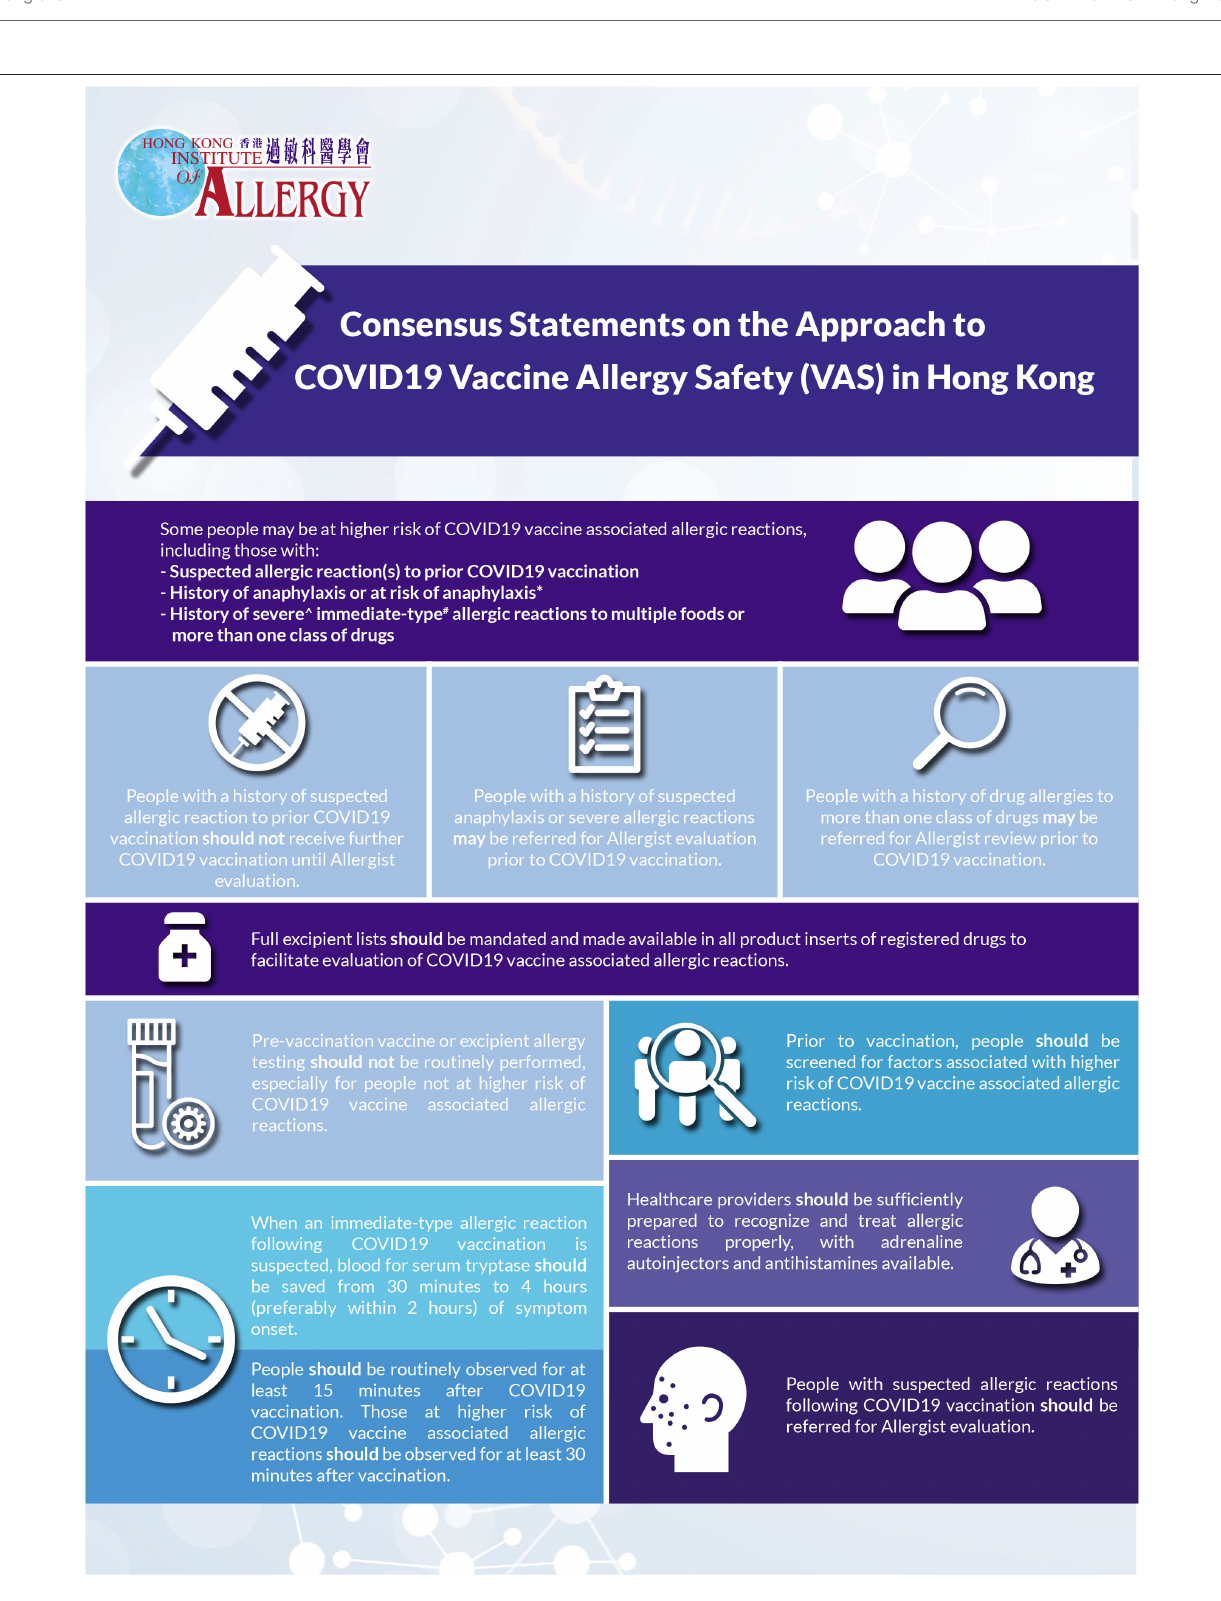
FIGURE 1 | Graphical summary of consensus statements (CS).